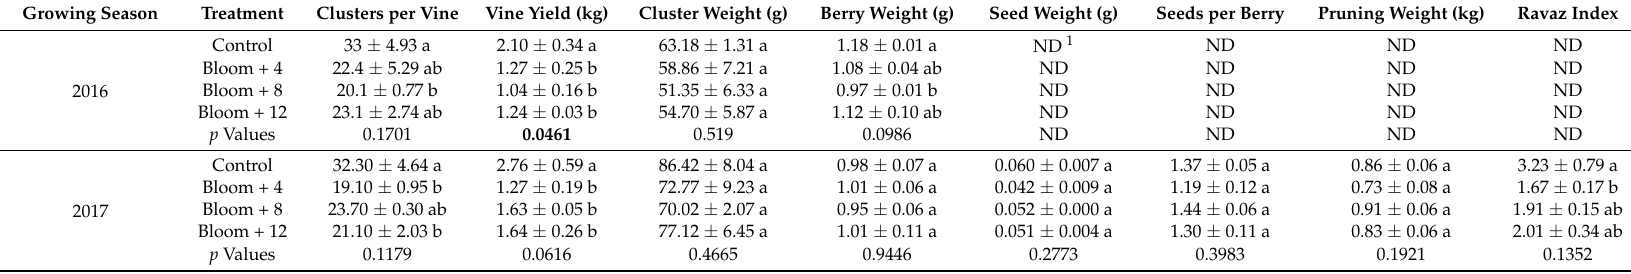
Table A1. Vine fruit yield and fruit physical composition by treatment and growing season. Treatment means followed by standard error of the mean. Different letters within a column and growing season indicate significant differences between treatment groups for Fisher’s least significant difference (LSD) test at p <